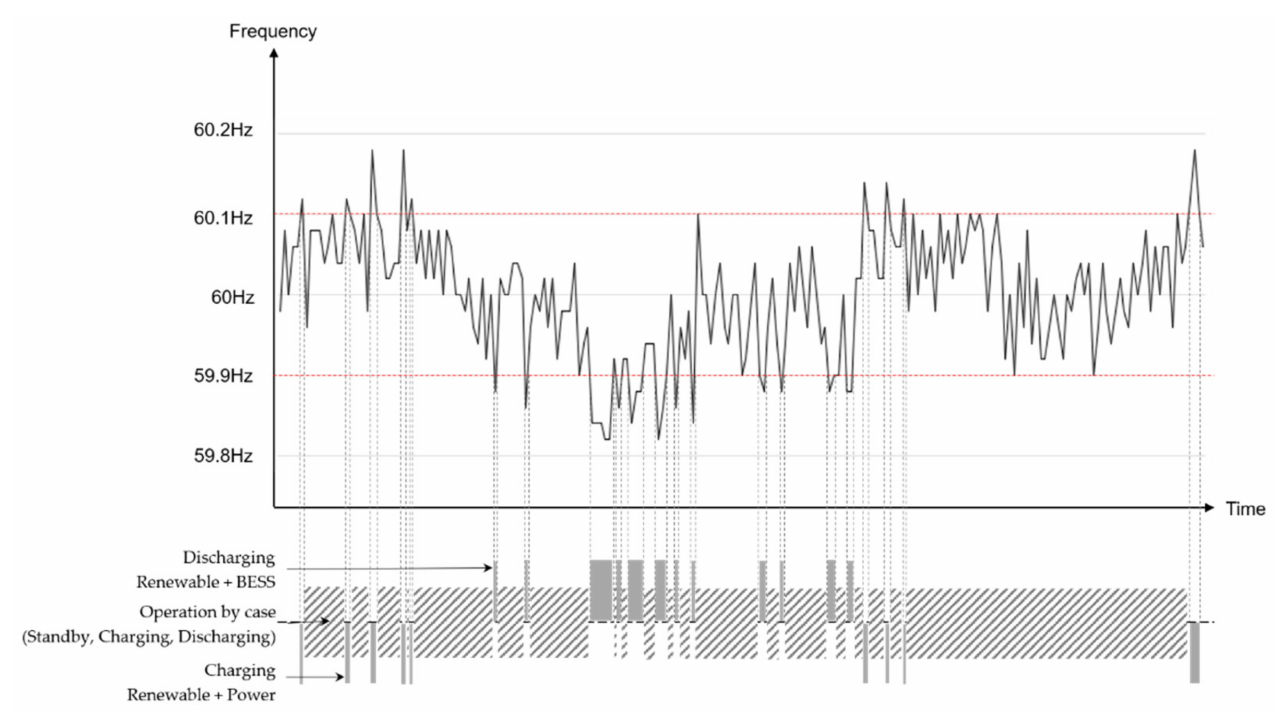
Figure 4. Concept of the frequency regulation